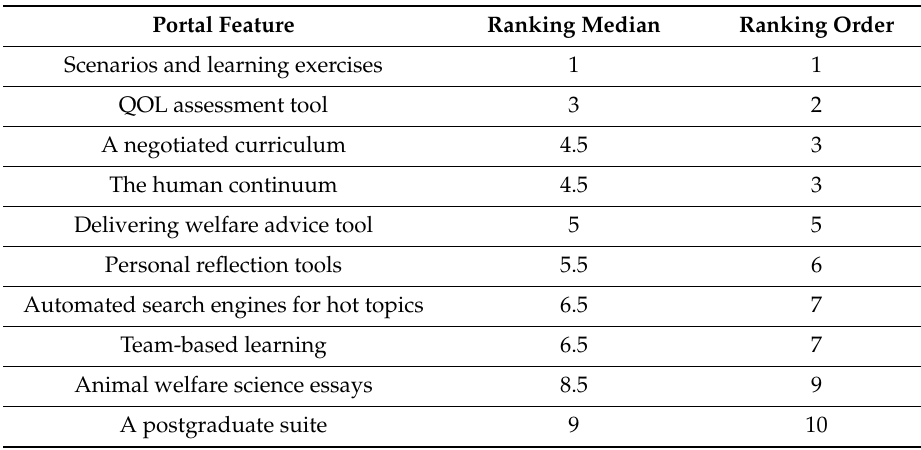
Table 3. Panel of educators’ ( n = 142) ranking of portal